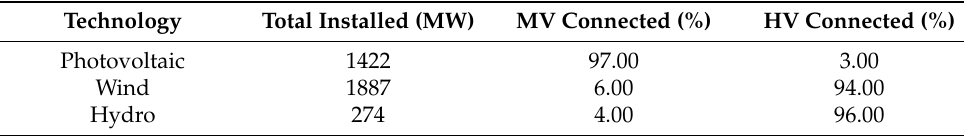
Table 3. Current RES installed in Sicily (beginning of 2020)